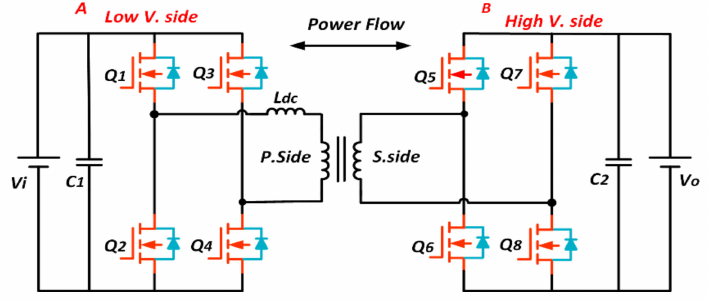
Figure 12. Isolated DAFB bidirectional DC-DC converter